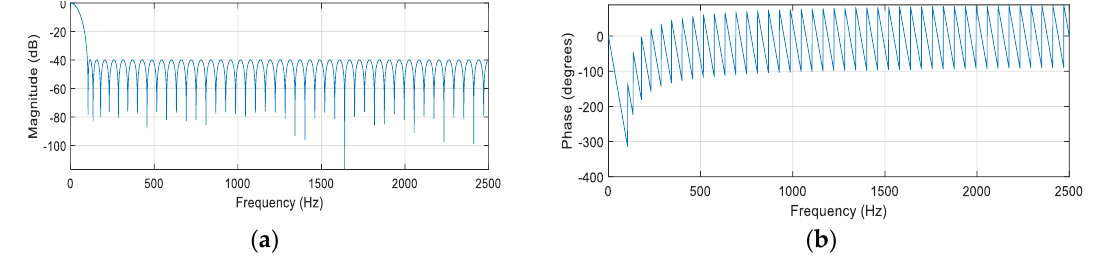
Figure 2. Amplitude — ( a ) and phase — ( b ) frequency characteristics of DFIR filter. Comparison between DFIR and MAF The frequency characteristics of a moving average filter method (MAF) are shown in Figure 3.